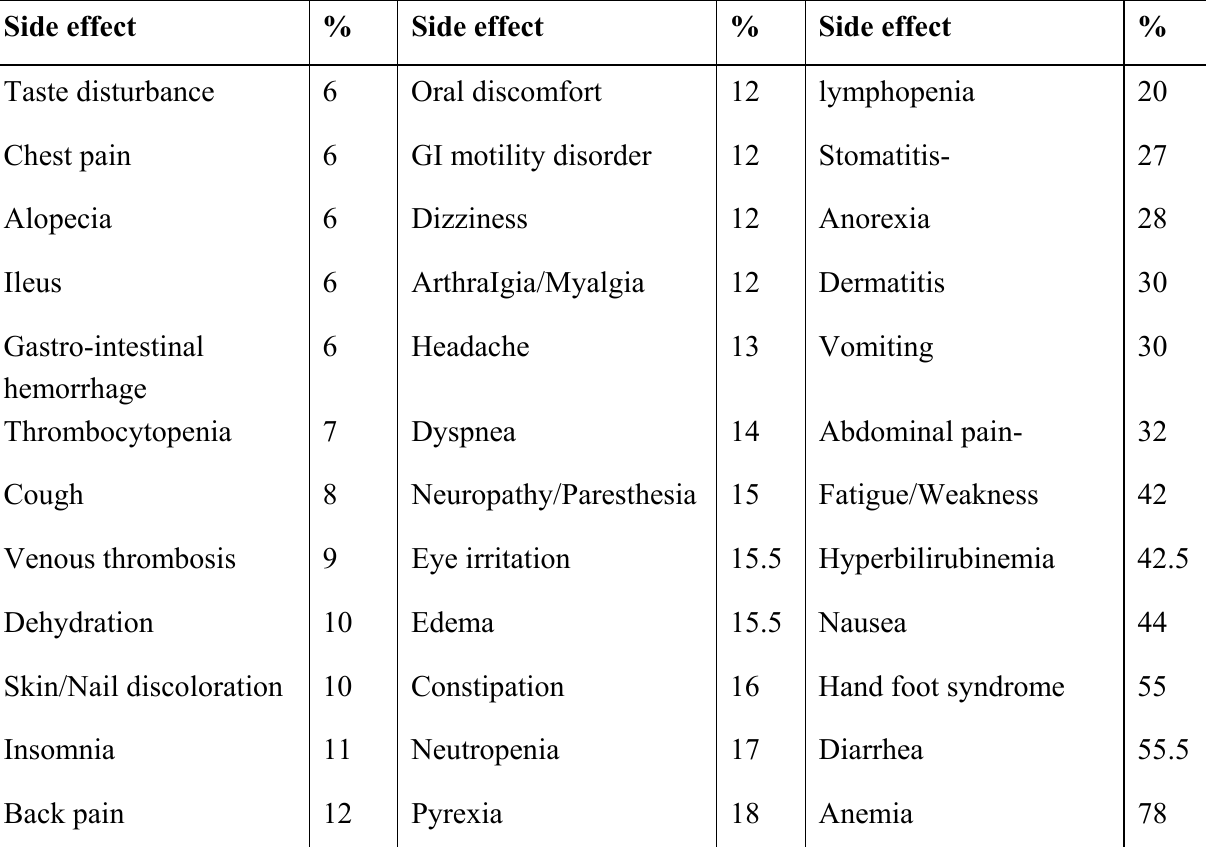
Table 1. Incidence of adverse effects in 758 patients with breast and colorectal cancer based on the evidence of three trails. All patients received 2,500 mg/m 2 capecitabine per day in 2 divided doses for 14 days, followed by 1 week without